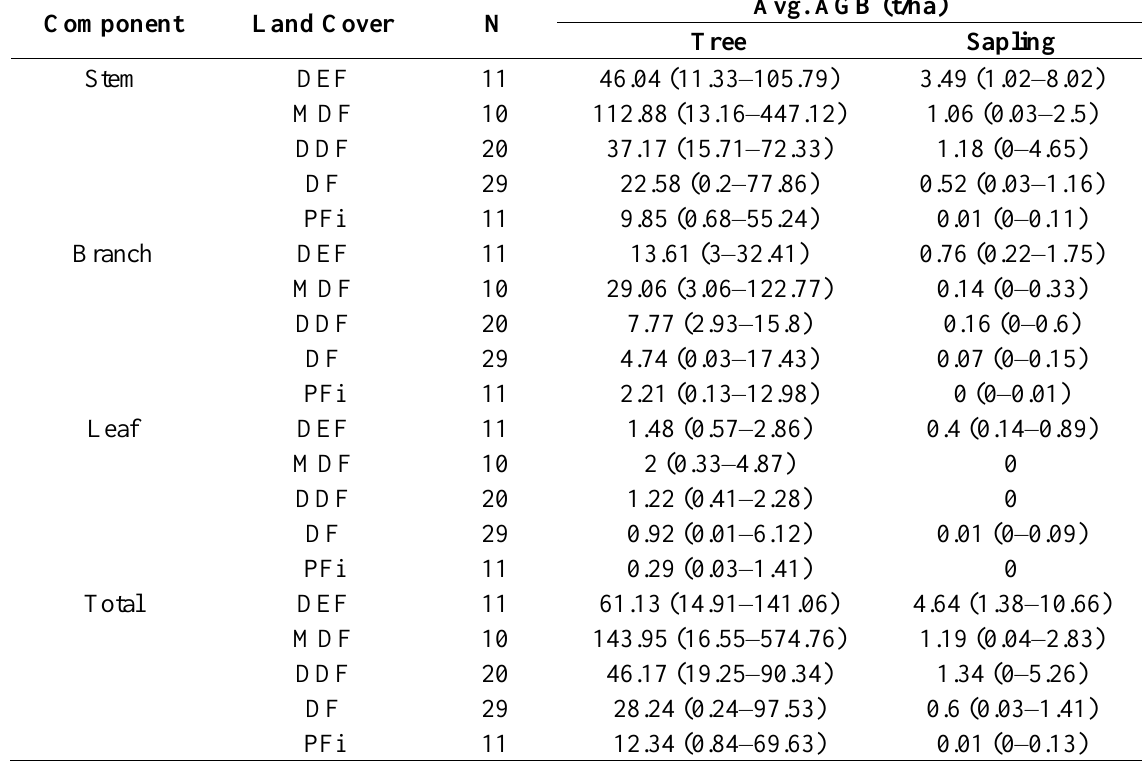
Table 4. The AGB of each tree and sapling component by vegetation